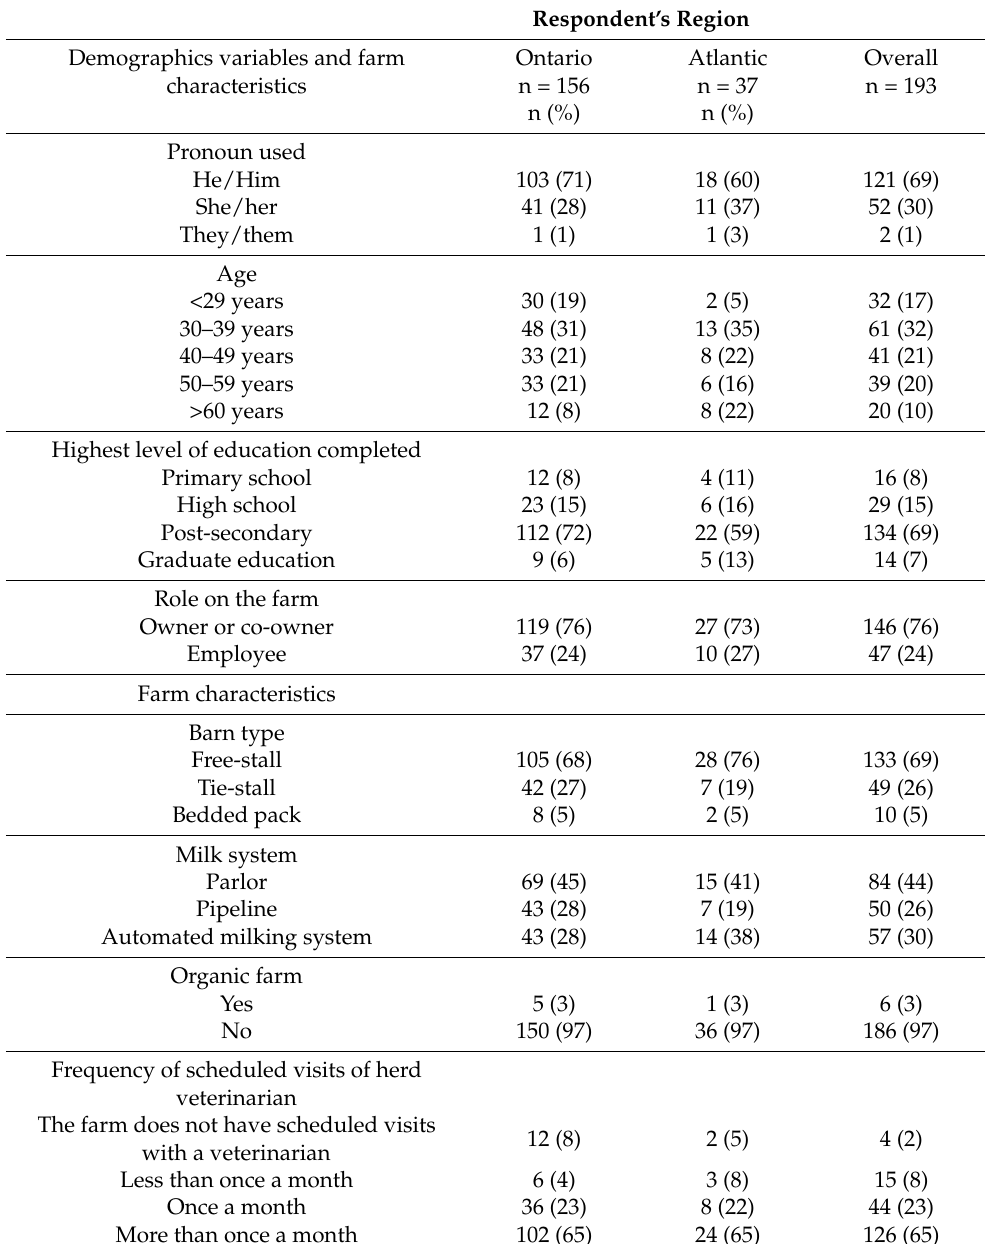
Table 1. Demographics and farm characteristics of 193 respondents to a questionnaire on antimicrobial use by dairy farmers in eastern